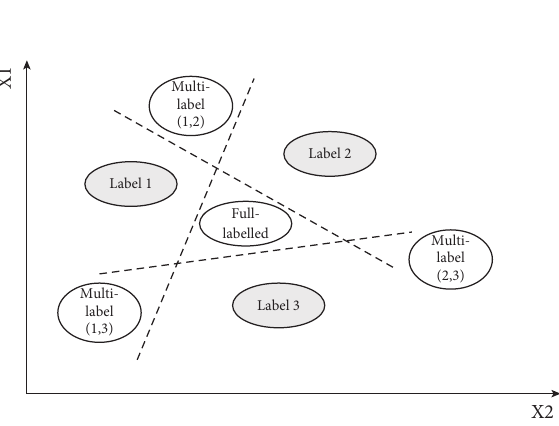
Figure 4: Labels for different